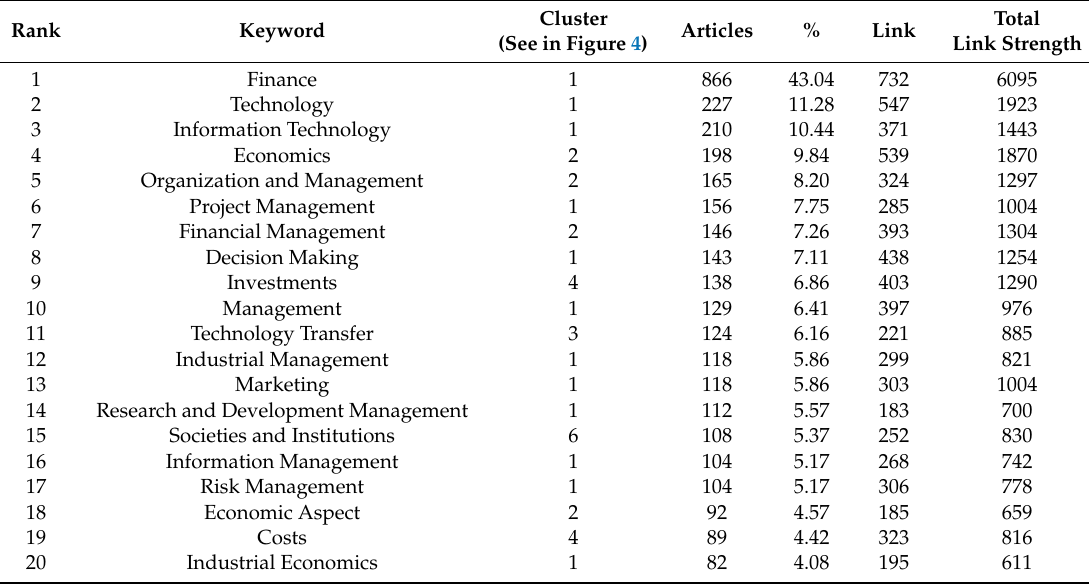
Table 4. Top 20 keywords